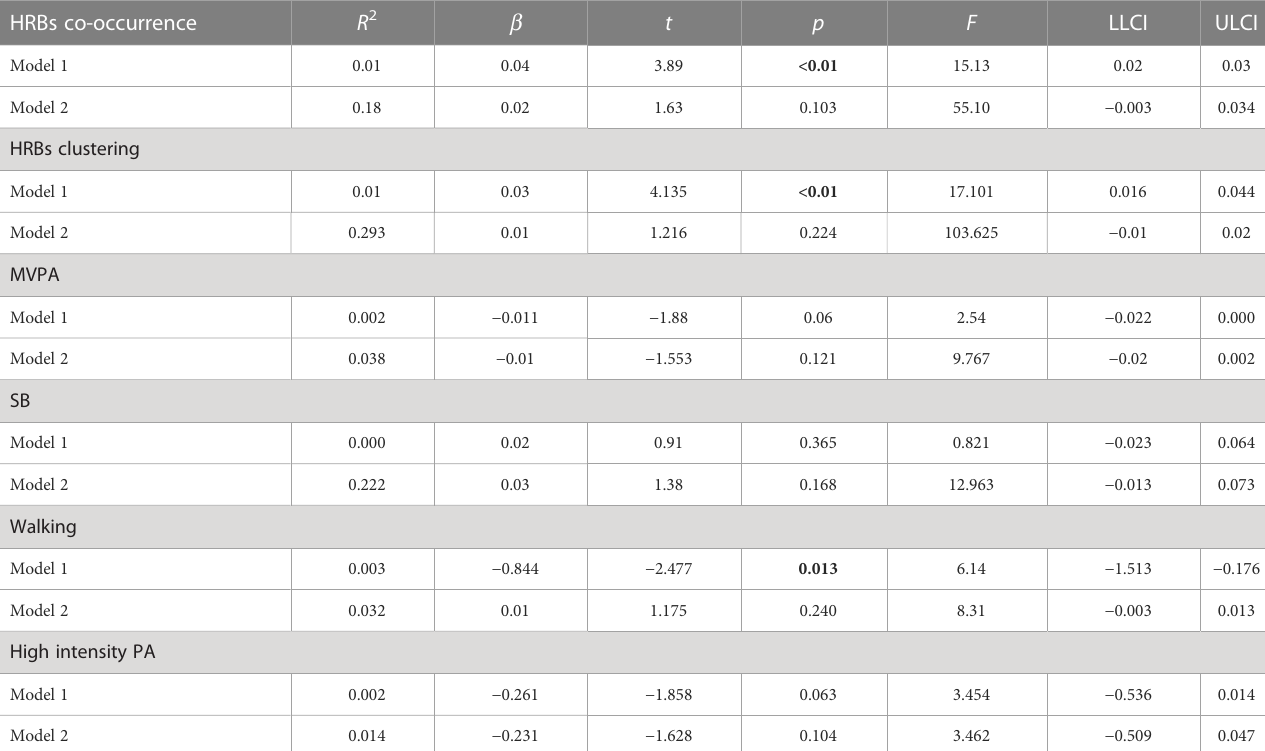
Model 1 Model 2 0.222 Walking Model 1 Model 2 0.032 High intensity PA Model 1 0.002